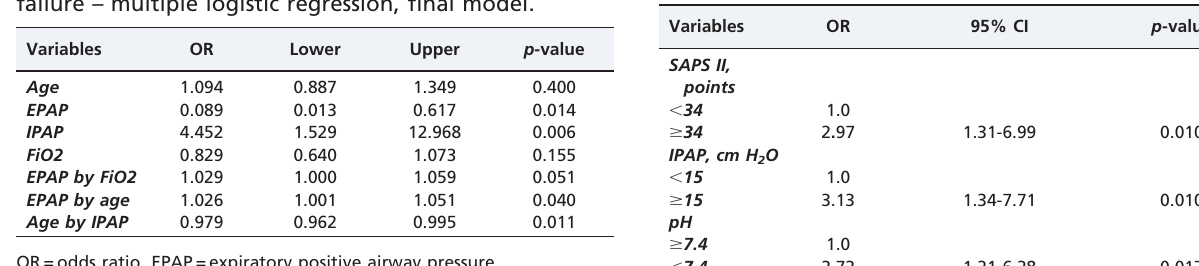
Events associated with NPPV use, n(%)